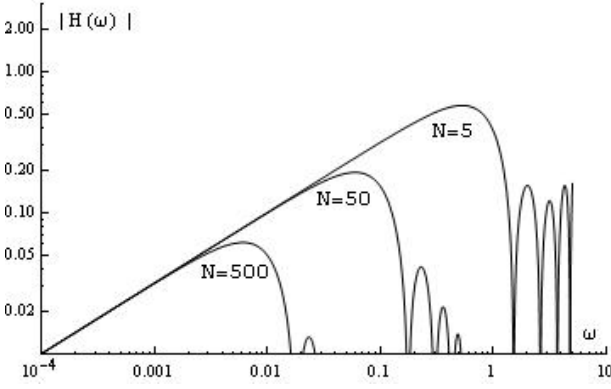
Figure 5. Moduli of the frequency response of the fractional Gram derivative with ν = 0 . 5 .